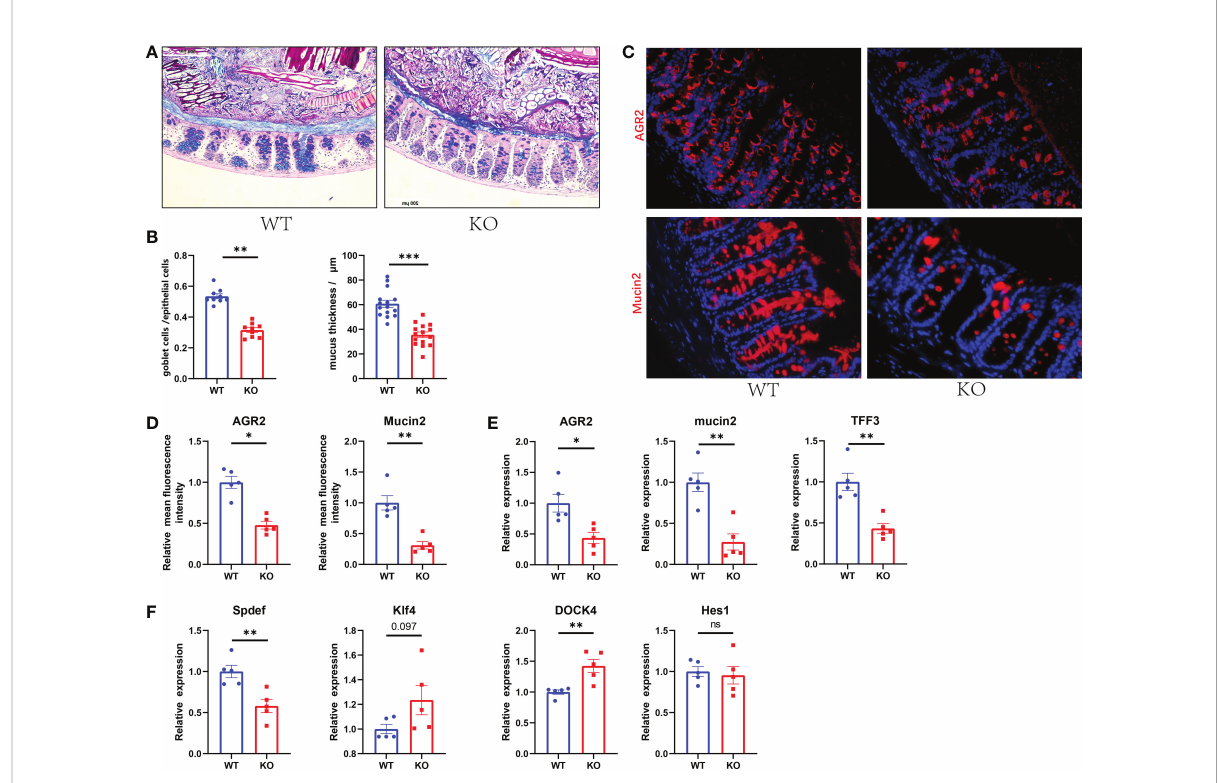
FIGURE 3 Decreased GC numbers and weakened mucus layer in GC Piezo1-/- mice. (A) The mucus layer in colon tissue by AB-PAS staining. 200×. (B) the number of goblet cells and the thickness of the inner mucus layer from two groups. (C) The typical immuno fl uorescent images of colon tissues were stained with DAPI (blue) and Mucin2 (red) or AGR2 (red) and were observed using a confocal laser-scanning microscope. 400×. (D) The relative mean fl uorescence intensity of AGR2, Mucin2. (E) The relative mRNA expression of Mucin2, AGR2, and TFF3 in colonic tissue. (F) The relative mRNA expression of DOCK4, Hes1, Spdef, and Klf4 in colonic tissue. Data are expressed as the mean ± SEM. (n = 5). *p < 0.05, **p < 0.01, ***p < 0.001;. ns, no signi fi